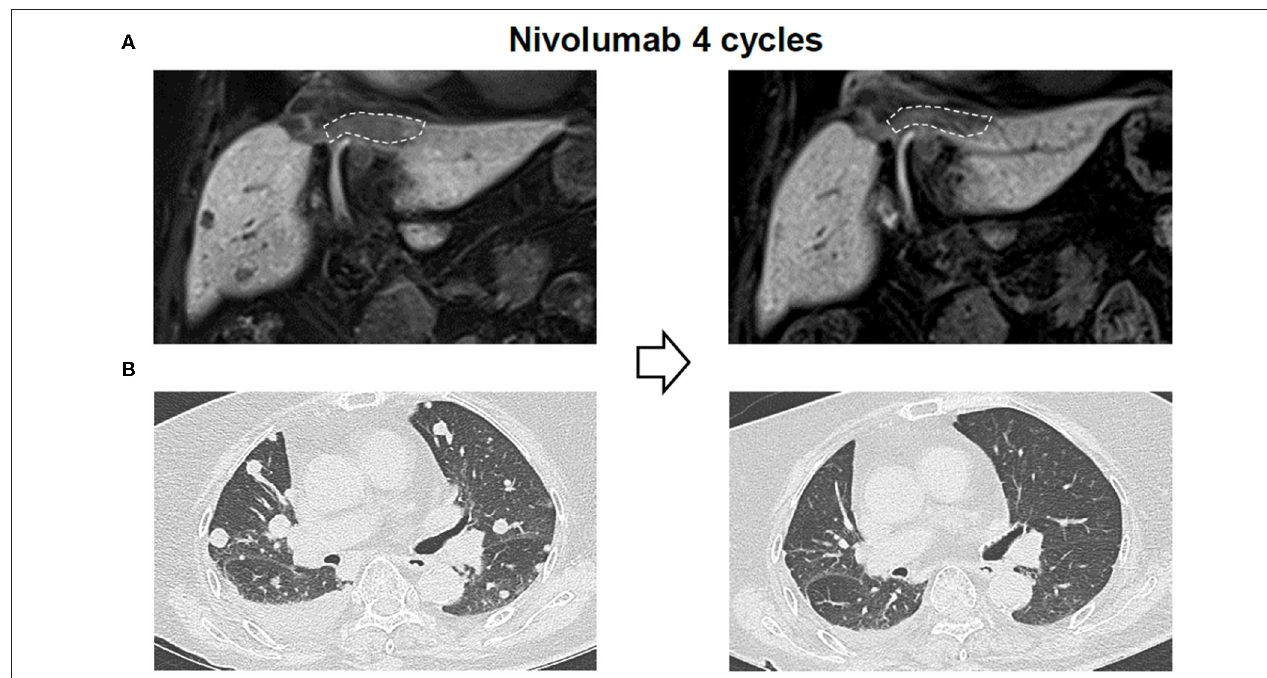
FIGURE 3 | Representative imaging data of a patient with heterogeneous responses to nivolumab. (A) Liver imaging findings after 4 cycles of nivolumab. (B) Lung imaging findings after 4 cycles of nivolumab.